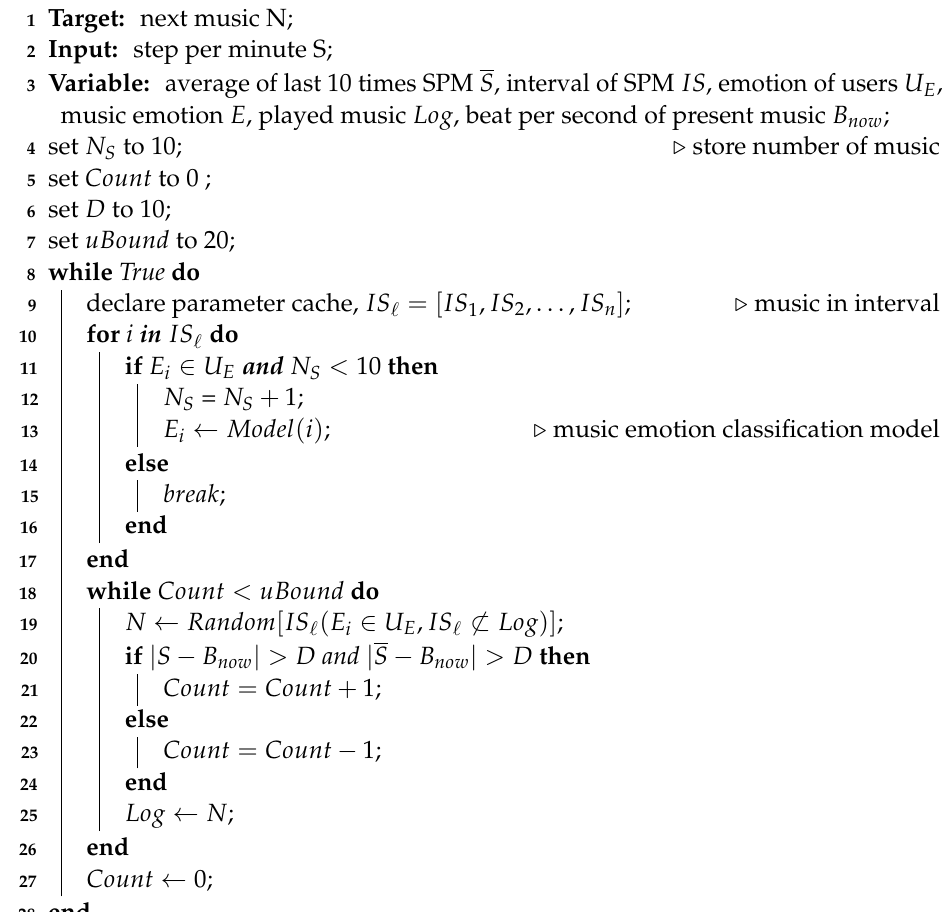
Algorithm 1: The music playing strategy with SPM and